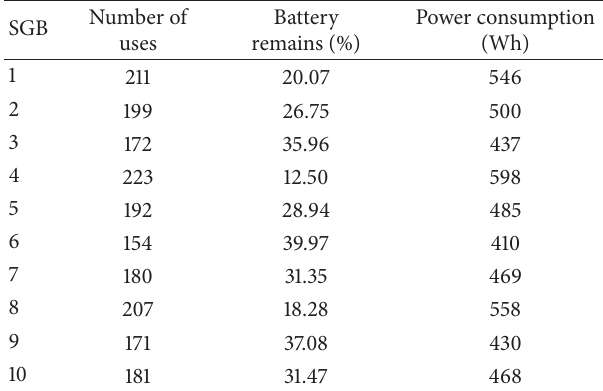
Table 4: Experimental results of Group